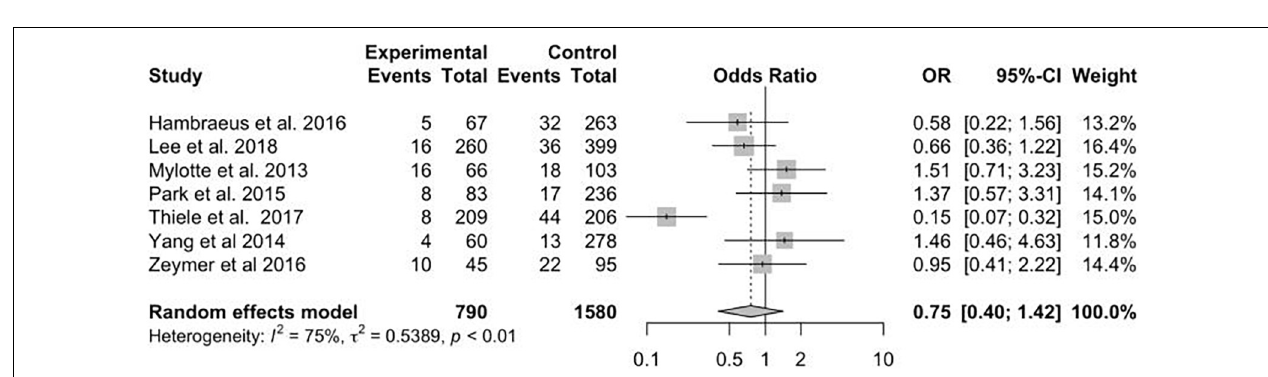
FIGURE 5 | Myocardial reinfarction (MI) with multivessel (MV) vs. culprit vessel-only (CO) percutaneous coronary intervention (PCI) in patients with ST-segment elevation myocardial infarction (STEMI) complicated by cardiogenic shock (CS).